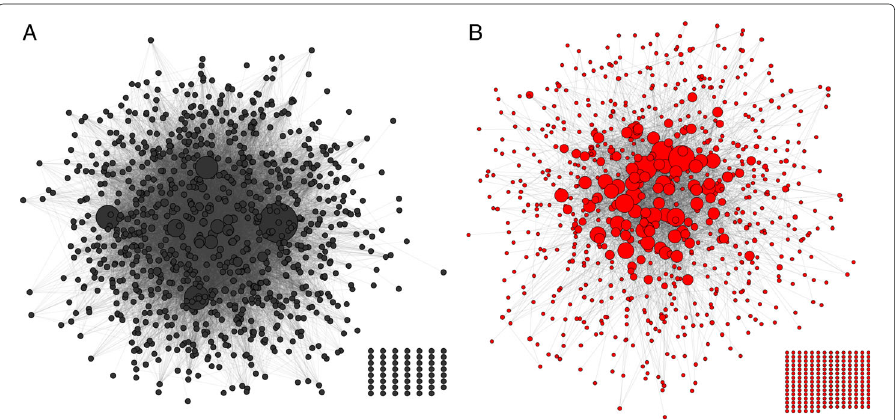
Fig. 5 The modular network structure in tumor and control. In this case, nodes are modules and the connections represent inter-module genes connected in the original network. a control module network. b Tumor module network